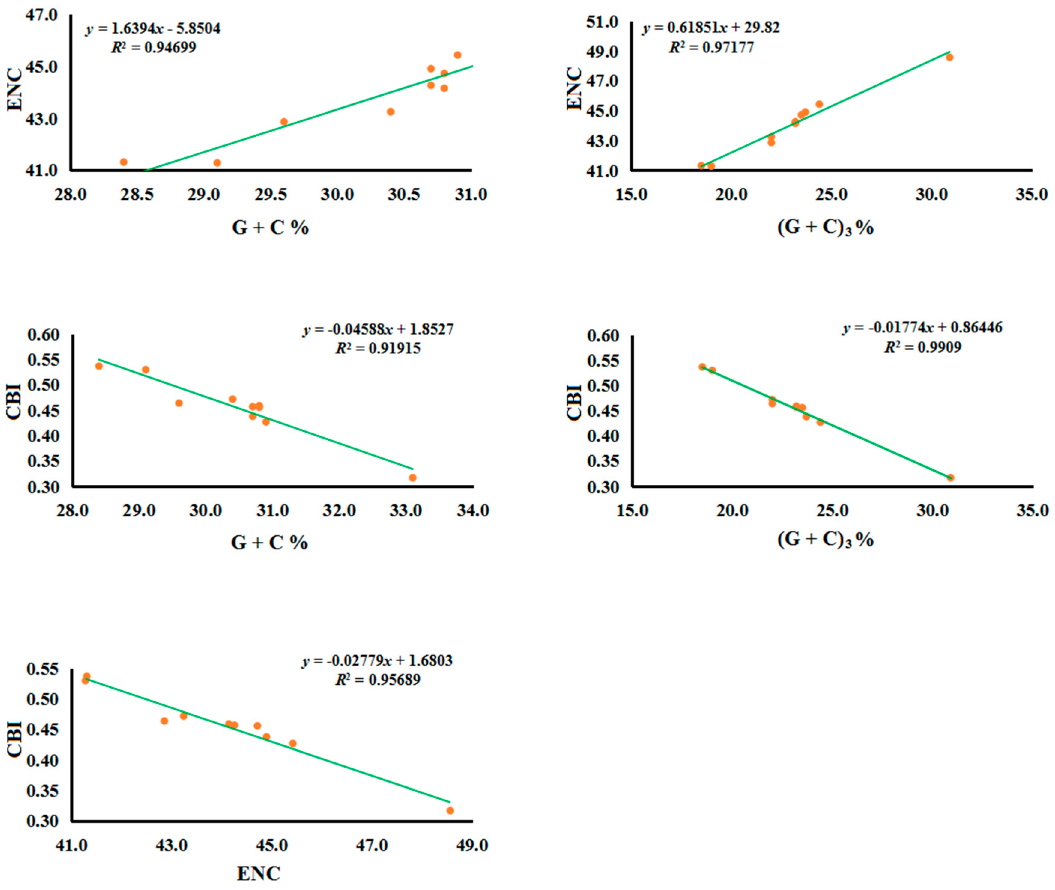
Figure 2. Evaluation of codon bias across ten Tenebrionidae mitogenomes. ENC denotes effective number of codons; CBI denotes codon bias index; G + C denotes GC content of codons; (G + C) 3 denotes GC content of the third codon positions.